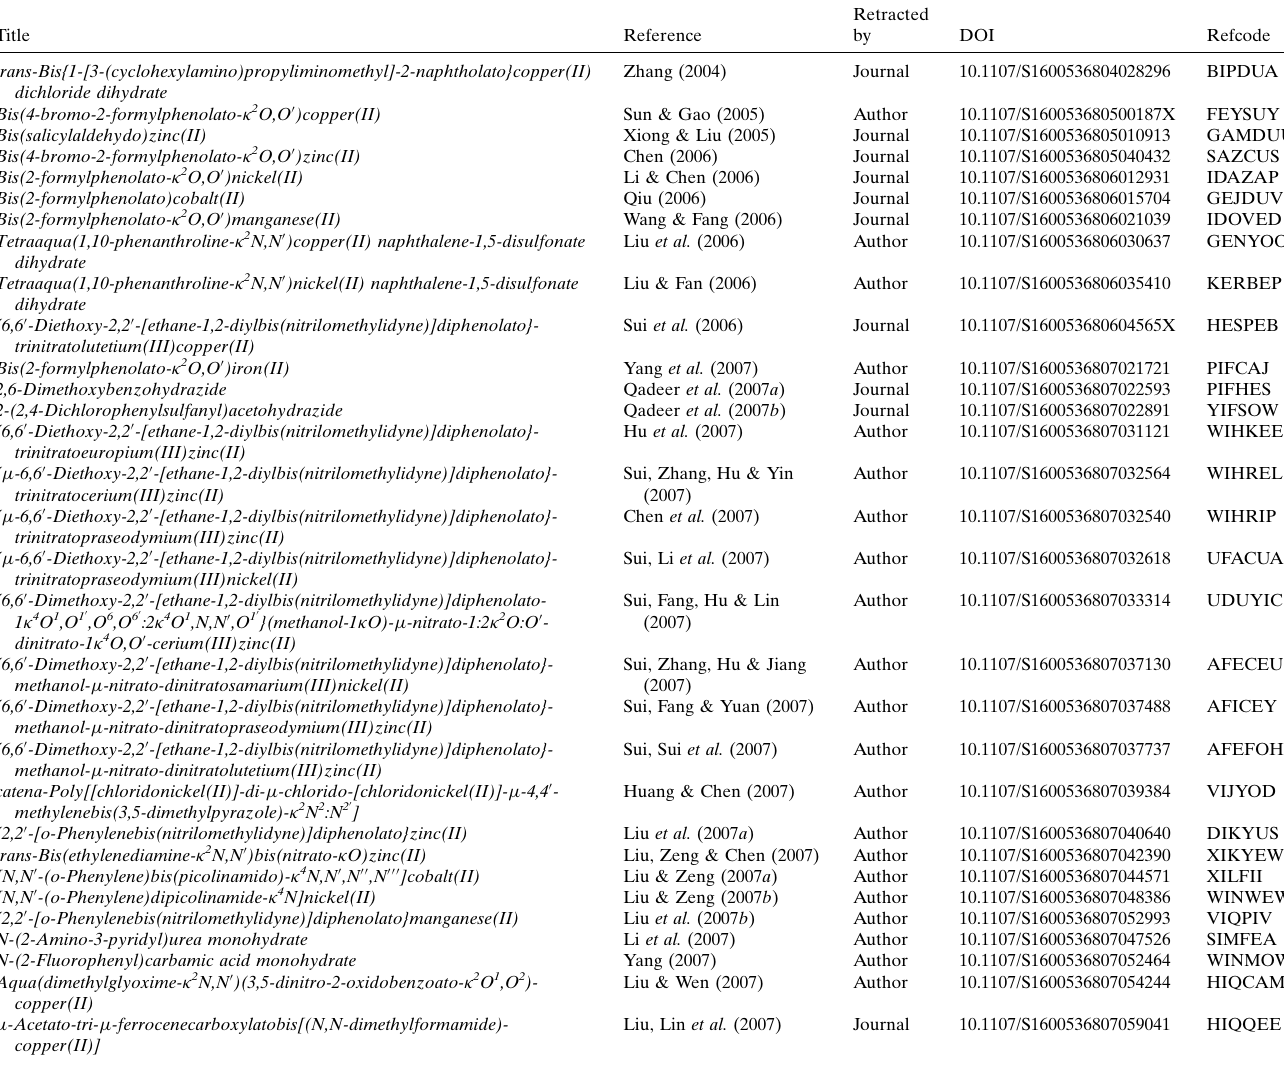
Details of articles to be retracted, in order of